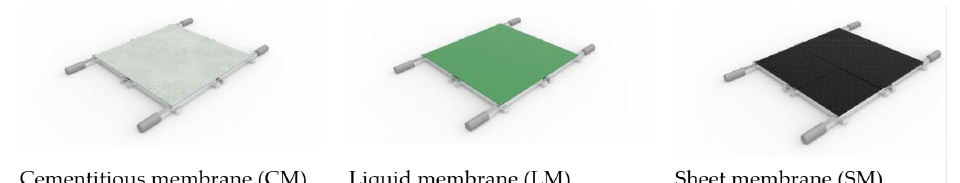
Figure 14. Specimens for